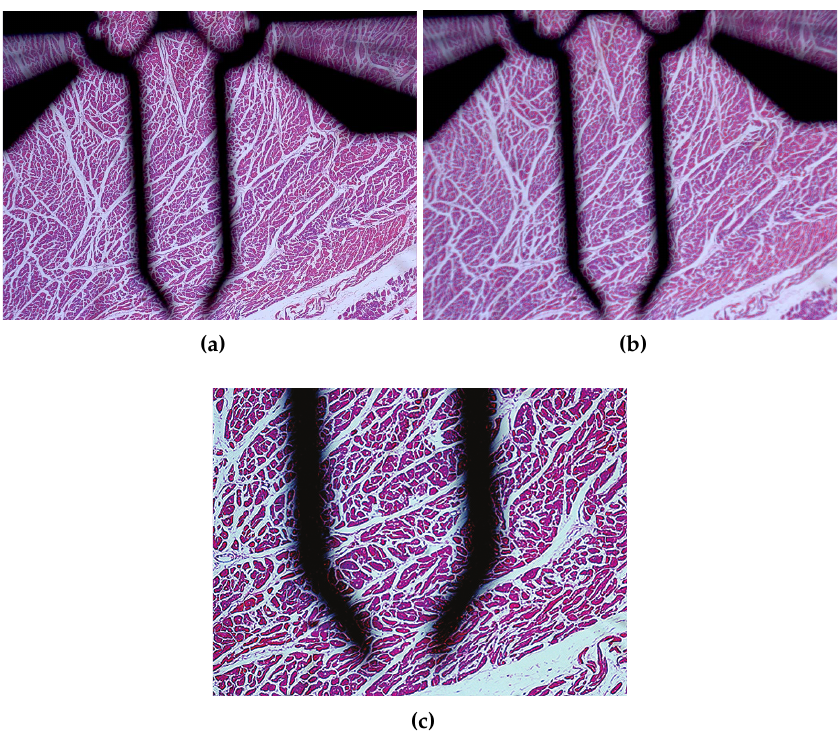
Figure 14. Heart tissue with gripper ( a – c ). ( a ) Heart (Focus a); ( b ) Heart (Focus b); ( c ) Heart (Focus